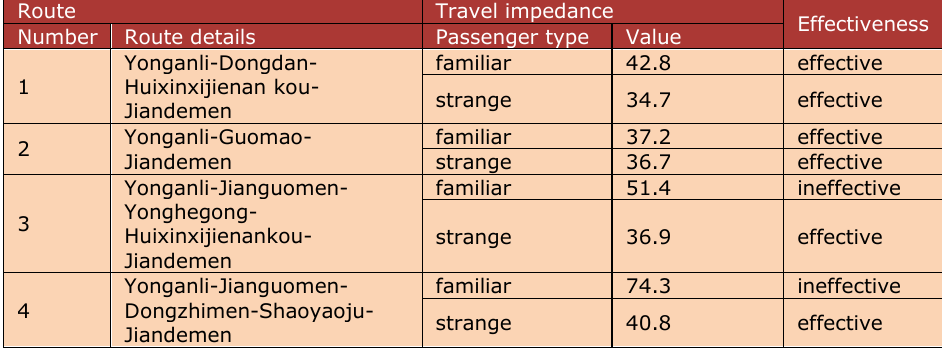
Table 4. OD Travel Routes